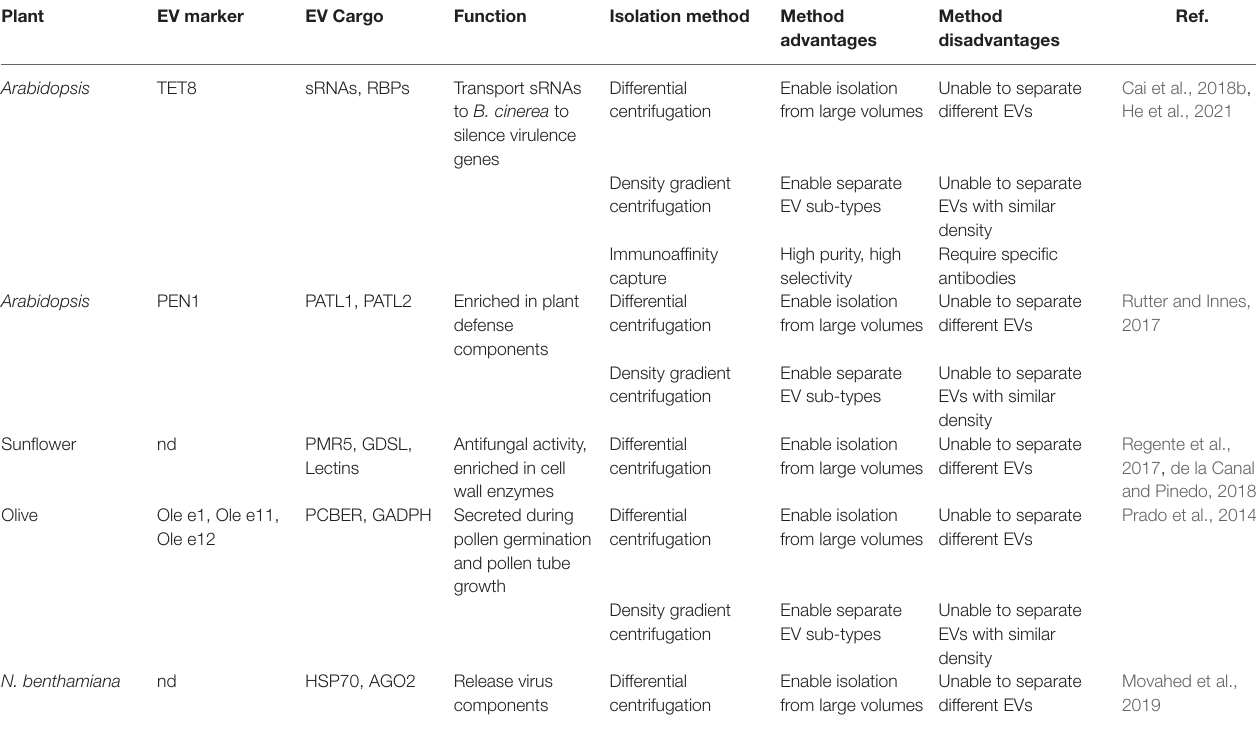
TABLE 1 | List of the protein markers, confirmed cargoes, isolation methods, and biological functions of various EVs isolated from plants.